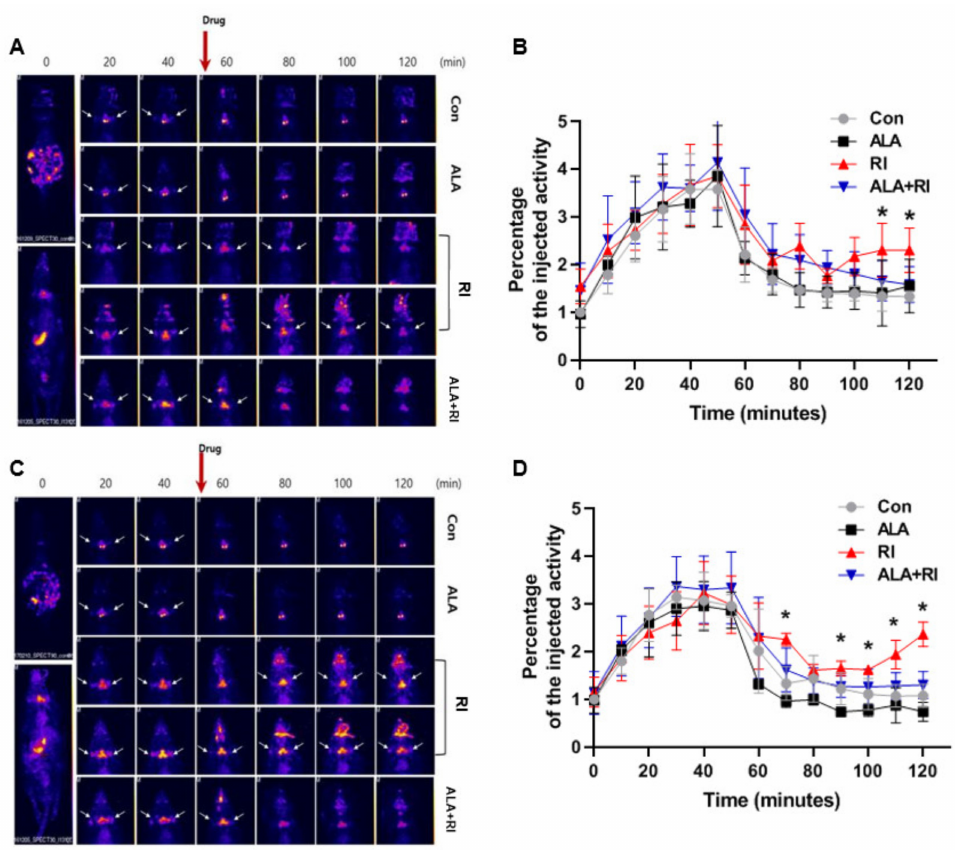
Figure 5. Planar whole-body images and dynamics of 99mTc pertechnetate uptake and excretion. ( A , C ) Representative single-photon emission computed tomography (SPECT)-scans of mice that underwent RI therapy. ( B , D ) The rates of 99mTc pertechnetate uptake were similar among all mice both 30 and 90 days after therapy. The level of excretion was significantly lower in the RI only group than the RI + ALA group, and the di ff erences in excretion were greater at 90 days than at 30 days. ( A , B ) 30 days post-RI therapy; ( C , D ) 90 days post-RI therapy. Data are means ± SD. * P < 0.05 compared to the RI only and RI + ALA groups. The drug is